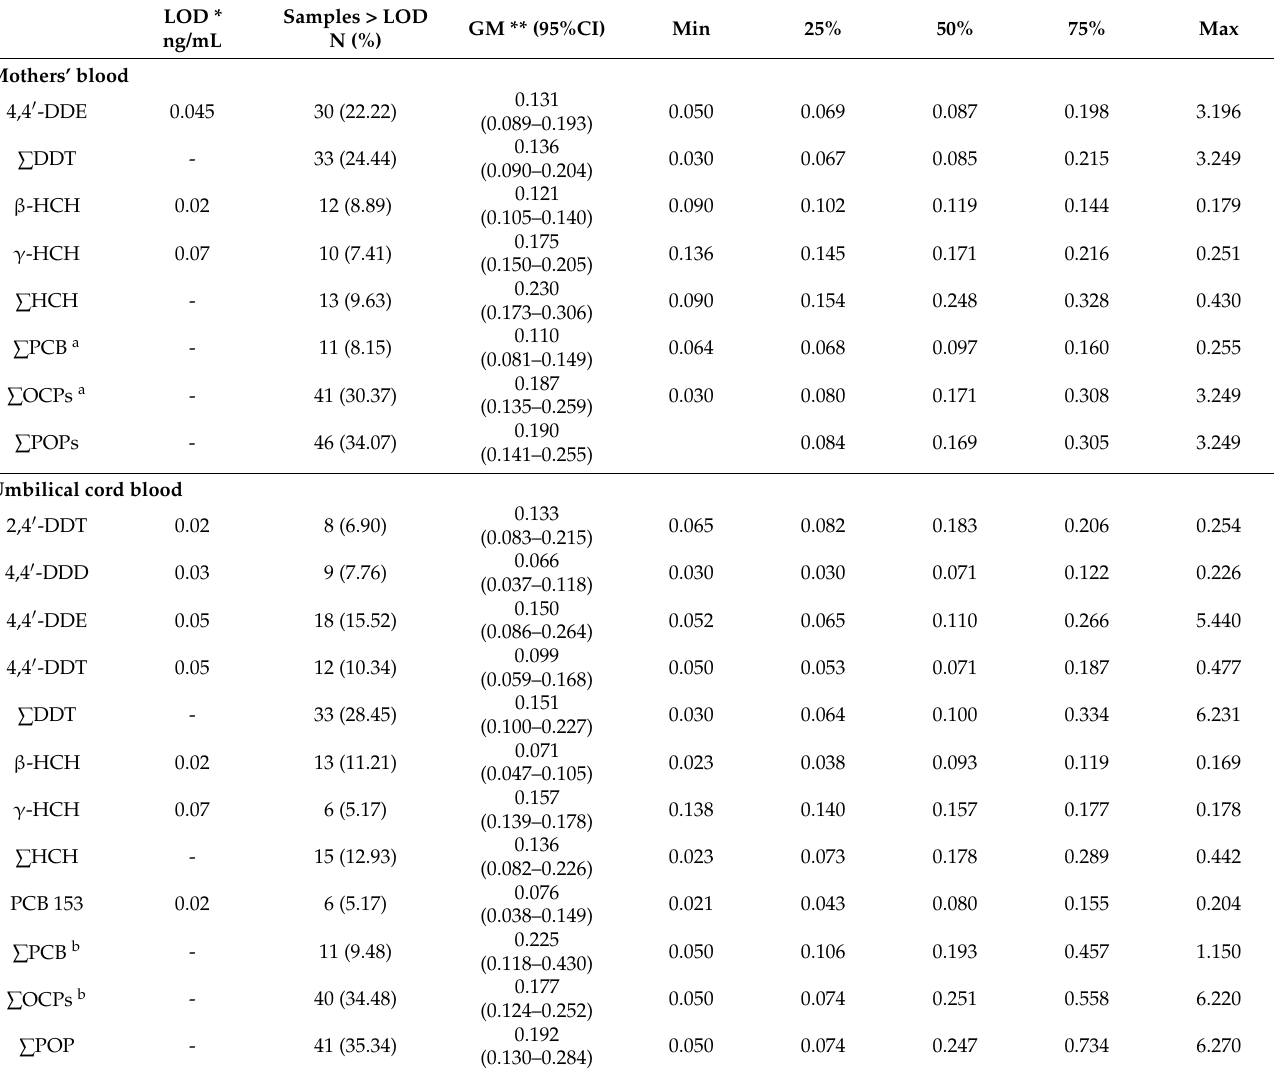
Table 2. OCP and PCB concentrations in maternal and umbilical cord blood of the Rio Birth Cohort pilot study. Rio de Janeiro, Brazil, September 2017 to February